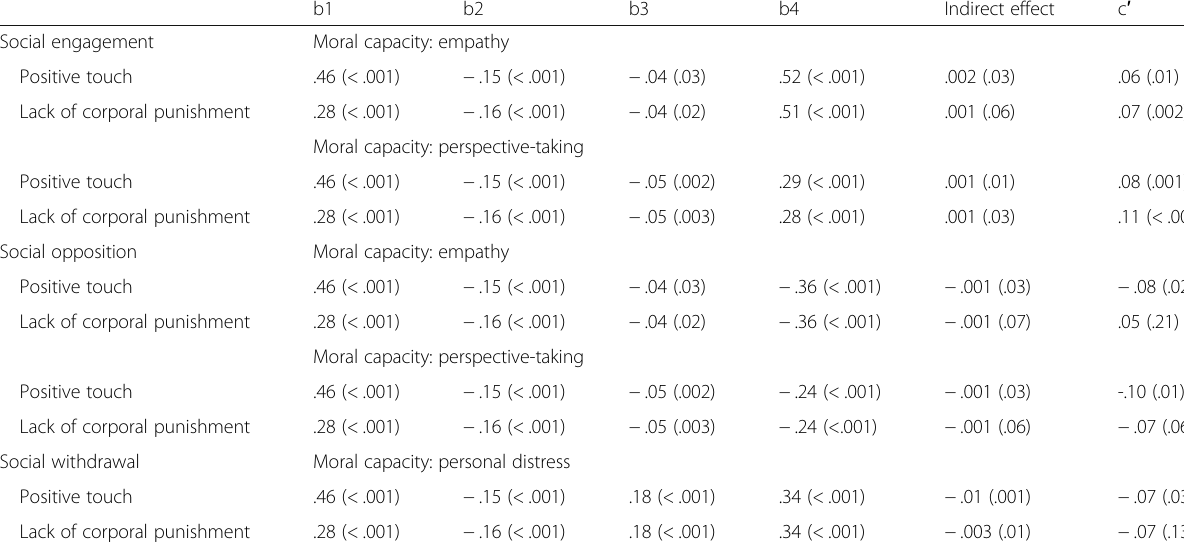
Table 5 Study 3 path coefficient estimates (and p values) among moral orientations and touch variables b1